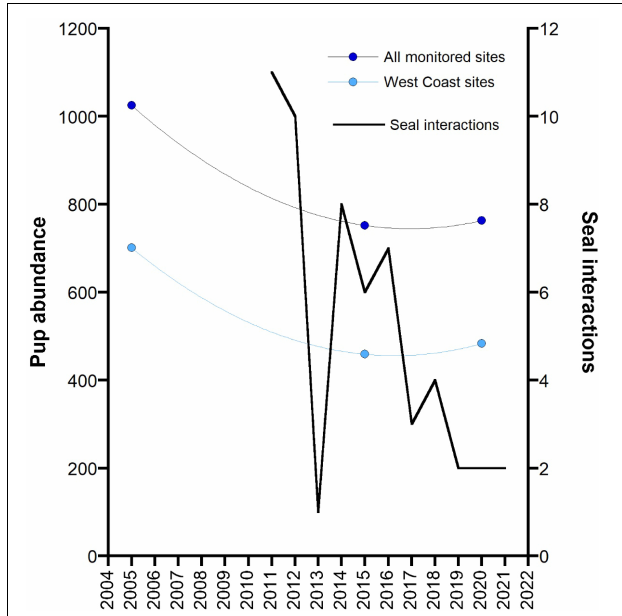
FIGURE 6 | Changes in the total pup abundance from 12 monitored ASL breeding sites in the area of the GHAT fishery off South Australia across three main survey periods: the mid-2000s (2004–2006), mid-2010s (2014–2015) and the late 2010s (2019–2020). Data for a subset of these sites on the west coast of the Eyre Peninsula (West Coast sites) are also presented. Both data sets are fitted to a second order polynomial. The reported number of interactions with seals in the GHAT fishery off SA since the introduction of 100% monitoring of fishing effort (2011) (by observers, electronic monitoring and vessel logbooks) are also